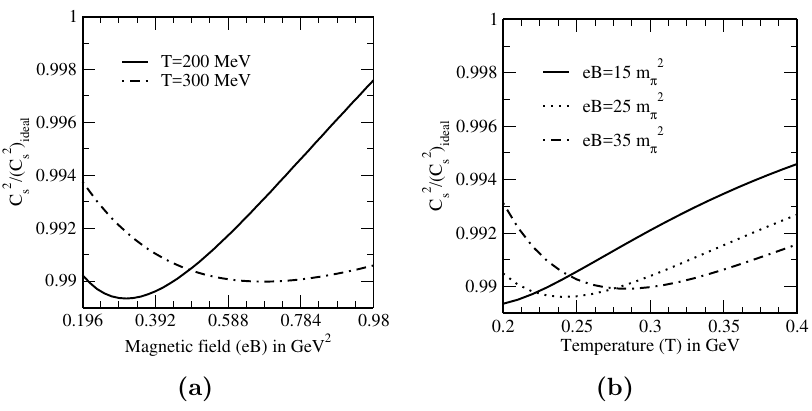
Figure 8 . The variation of c 2 normalized by its ideal value as a function of magnetic (cid:12)eld at s various temperatures (a) and as a function of temperature in the presence of varying strong magnetic (cid:12)elds